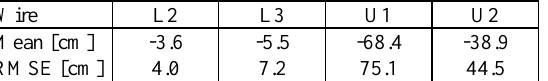
Table 5. Results of relative catenary comparison to